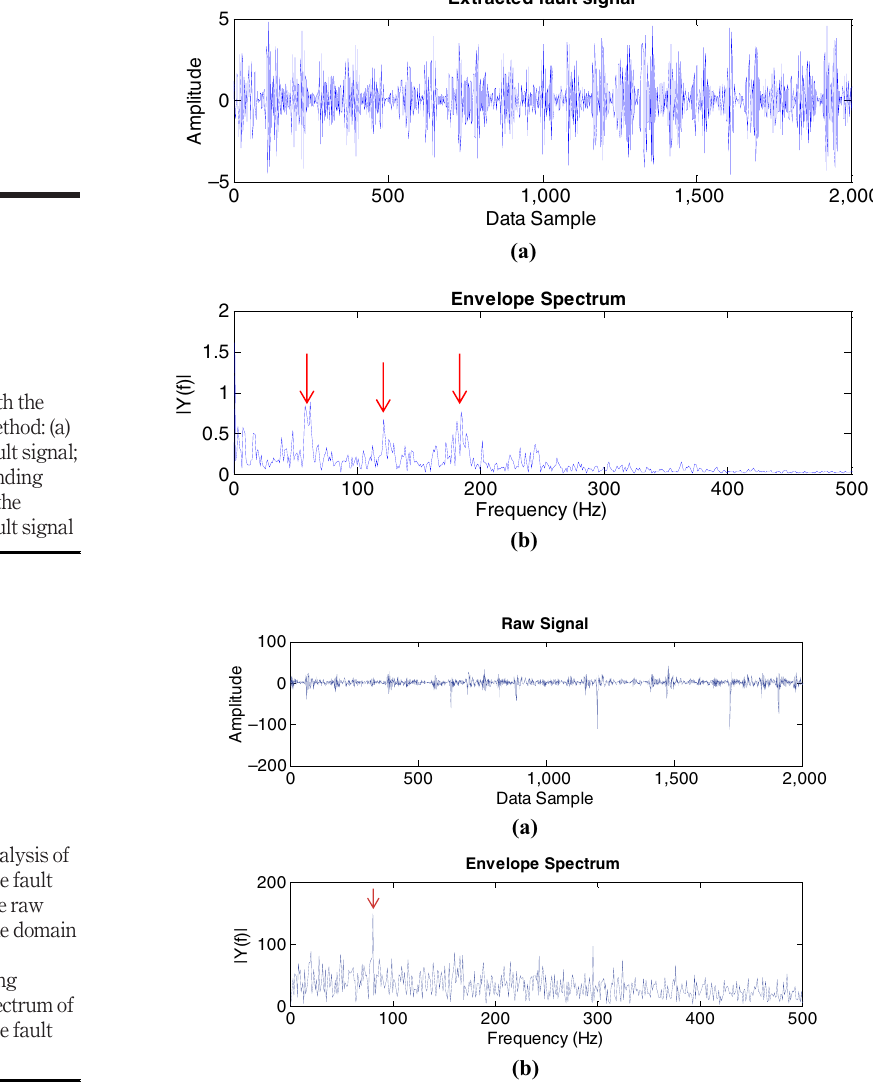
Figure 8. Analysis with the proposed method: (a) extracted fault signal; envelope of the extracted fault signal